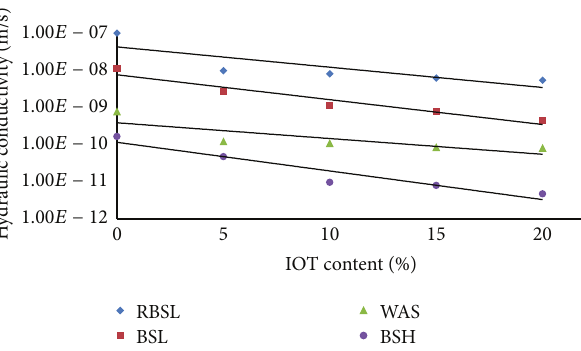
Figure 7: Hydraulic conductivity versus iron ore tailings content for compacted soil permeated with